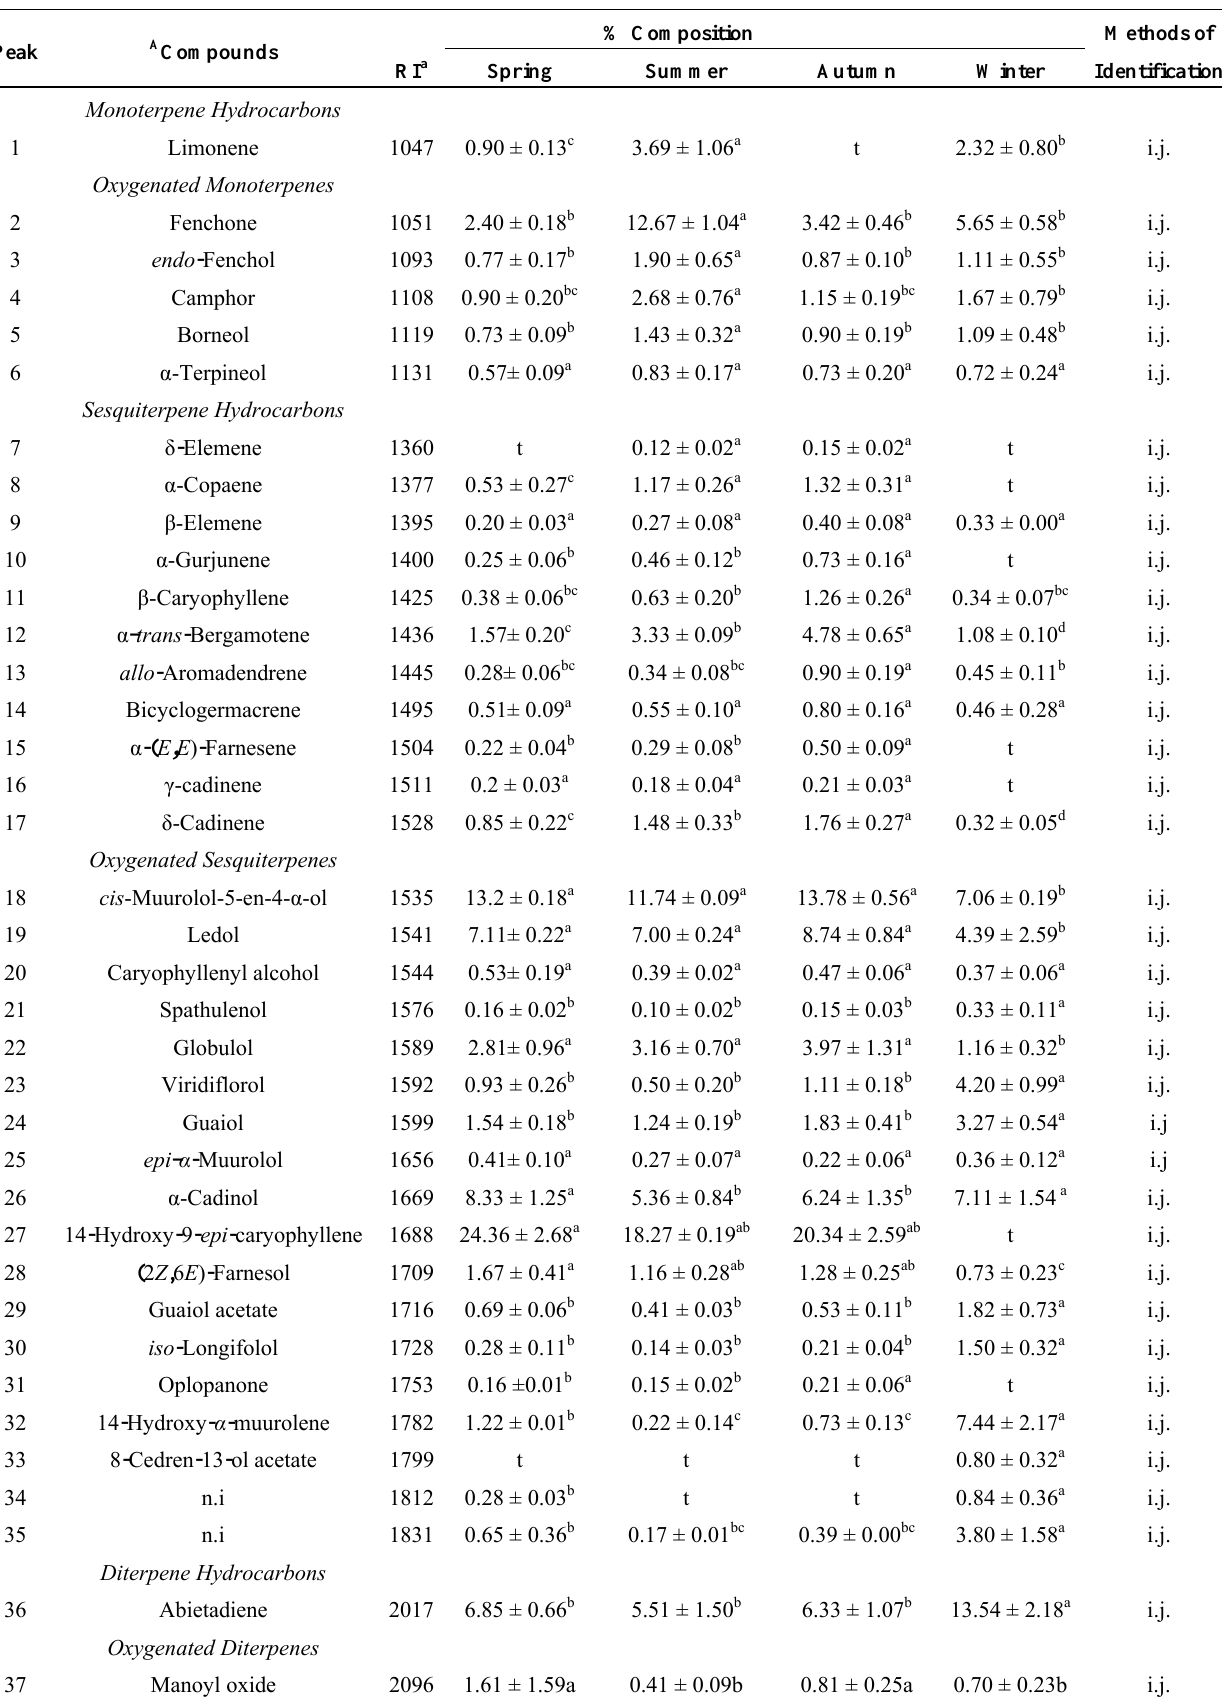
Table 1. Chemical composition of Tetradenia riparia essential